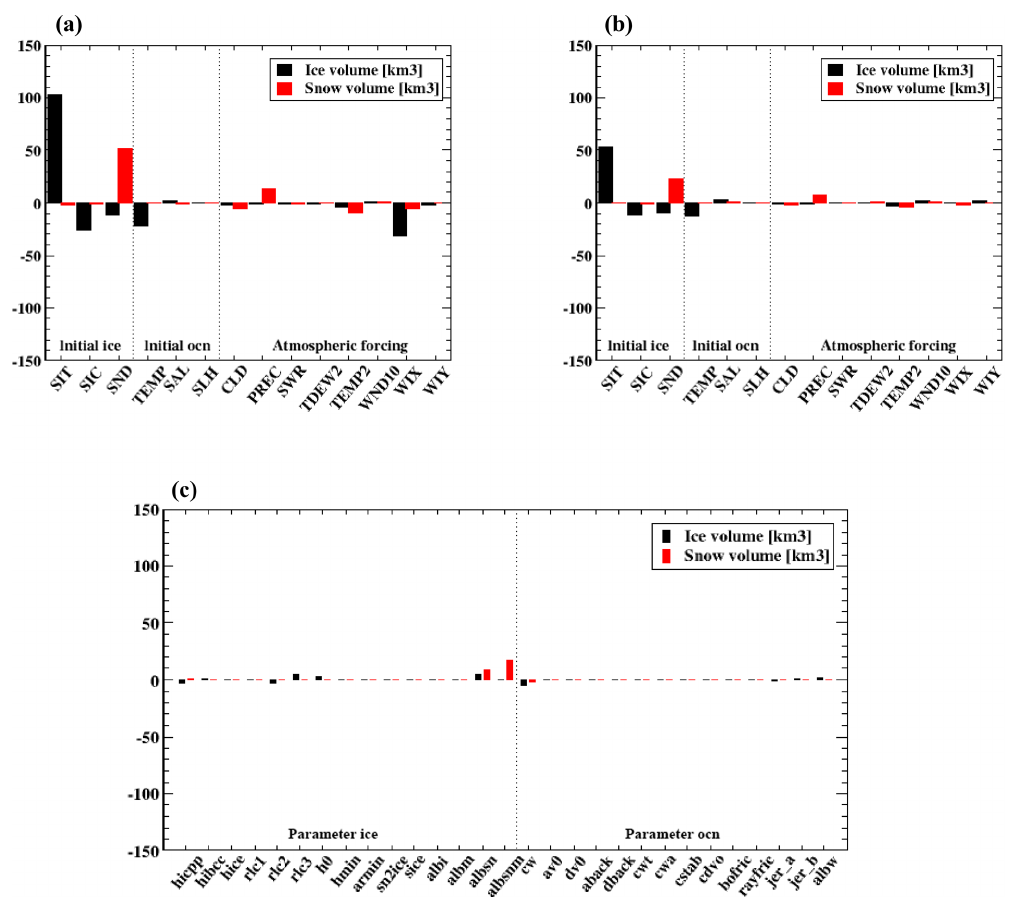
Figure 17. An excerpt of Fig. 16 for the target Jacobian (top) in target region 6 (East Siberian Sea – a ) and region 5 (Laptev Sea – b ) and (c) for the model